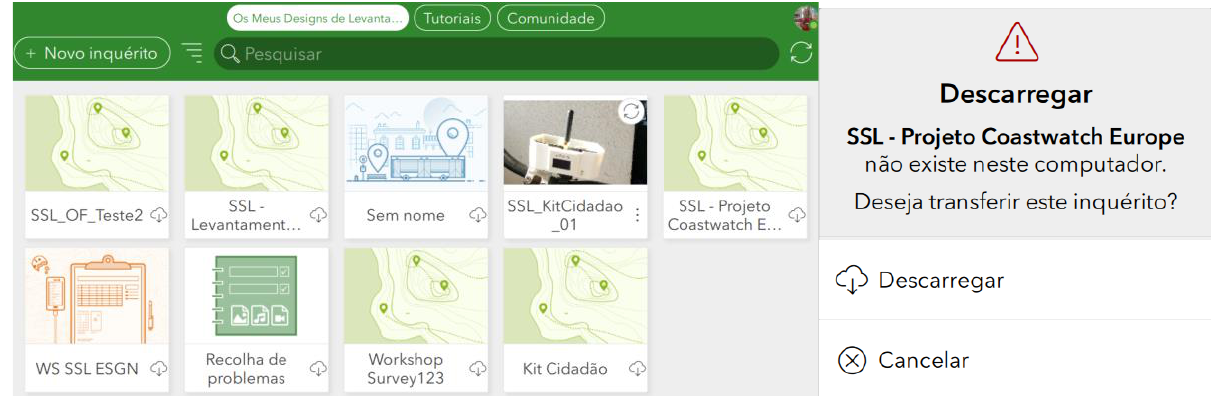
Figure 15. Survey 123 APP. Figure 15. Survey123